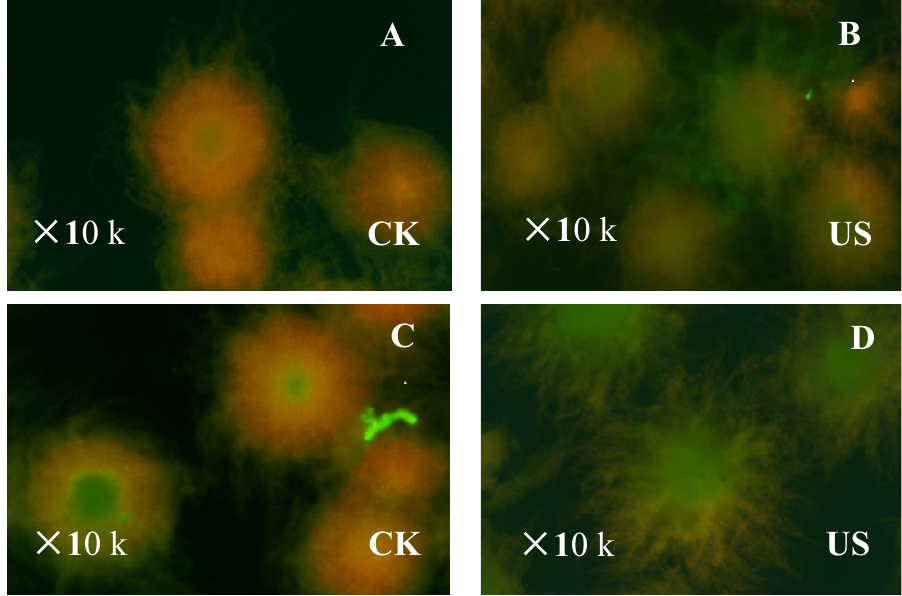
Figure 4. Mycelia-viability staining to observe the effect of ultrasound treatment on S. albulus. (Ultrasound treated for 30 min ( A , C ) and ultrasound treated for 60 min ( B , D ). Green or red means the distribution of dead and living mycelium in the cell; green means living cells with a relatively complete cell membrane, and red means dead cells with incomplete cell membrane).